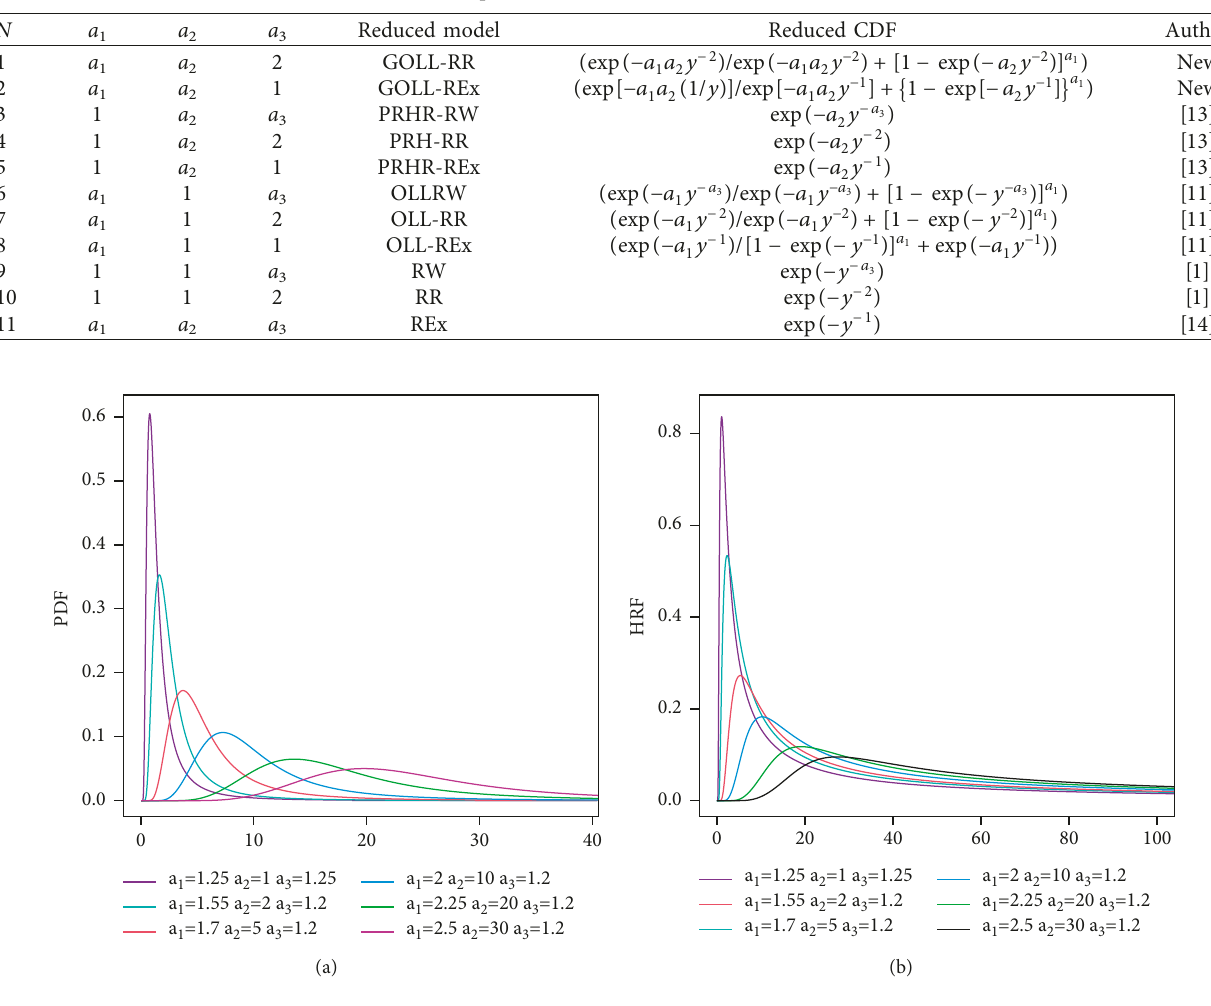
Table 1: Especial members of the GOLLRW